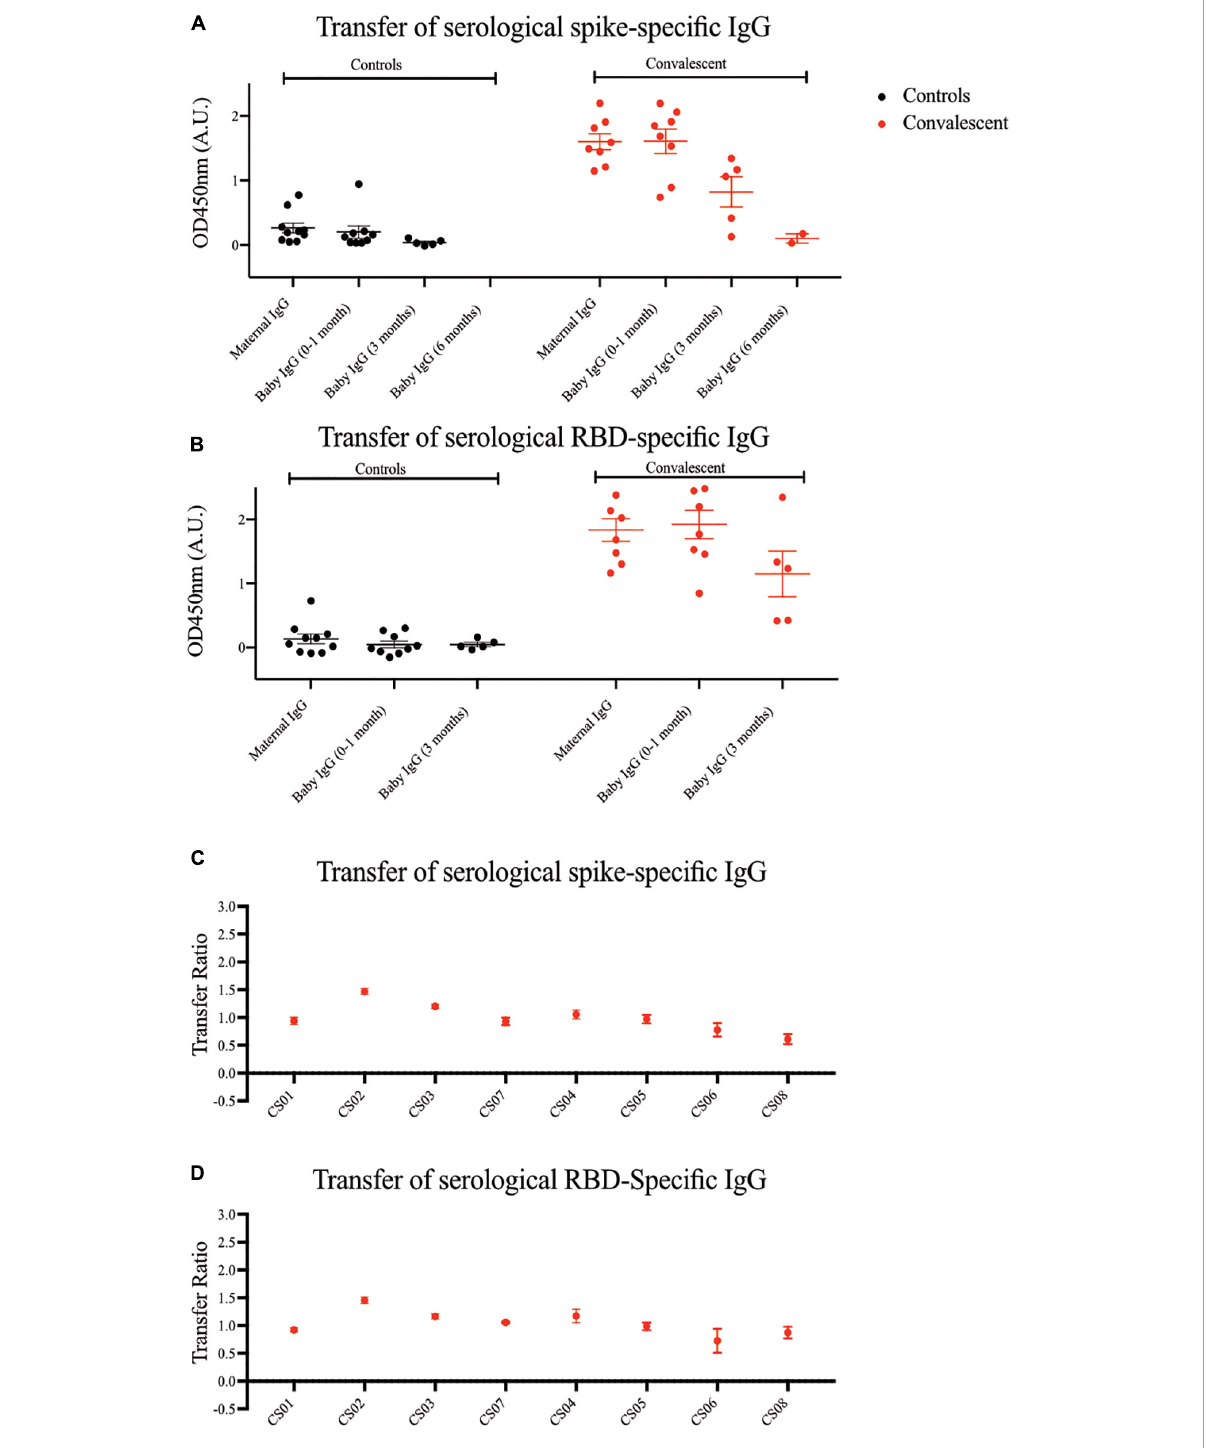
FIGURE4 Spike and RBD-specific IgG are passively transferred from convalescent mothers to infants. (A) Spike and (B) RBD-specific IgG from maternal plasma 1 month post-partum and at three time points from babies’ plasma was determined using ELISA. Transfer ratio at the 1 month timepoint of (C) spike and (D) RBD-specific IgG from mother to infant was calculated by taking the averaged IgG signal of baby’s over the mother’s IgG. Convalescent mothers (CS samples) are arranged in ascending order according to their time from COVID diagnosis to